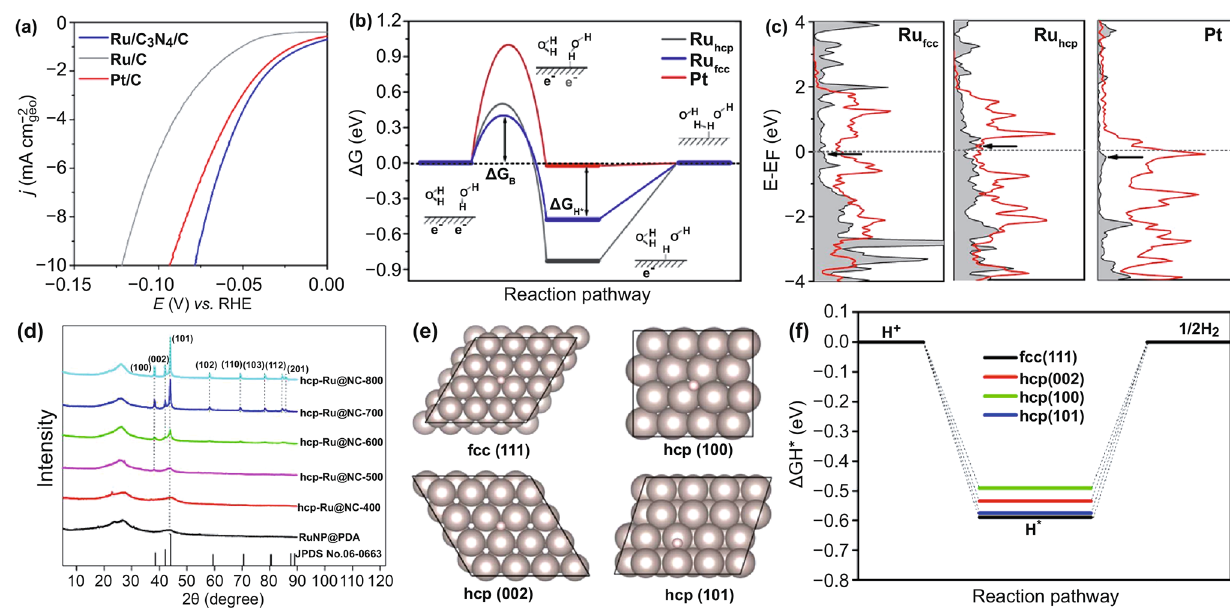
Fig. 3 a–c HER polarization curves, Gibbs free energy diagram of HER on different metal surfaces and local density of states projected for the adsorbed H atom (H-DOS, dark shaded area) on three metal surfaces [35], with permission from the American Chemical Society. d–f XRD pat- tern of RuNP@PDA and hcp-Ru@NC annealed at various temperatures ranged from 400 to 800 ℃ , H adsorption models and ΔG H* on different Ru surfaces, respectively [61], with permission from the American Chemical